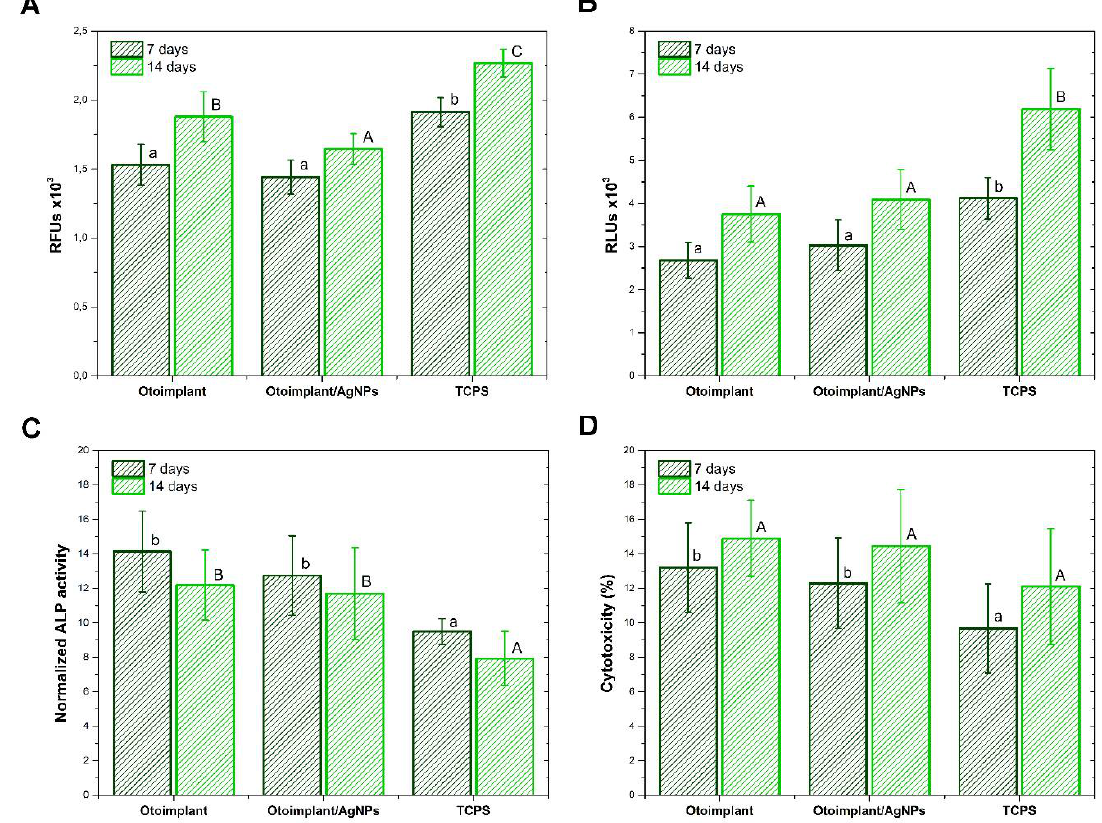
Figure 7. NHOst response after 7 and 14 days of culture in direct contact with the Otoimplant and Otoimplant/AgNPs: metabolic activity ( A ), the relative cell number ( B ), normalized alkaline phosphatase (ALP) activity ( C ), and cytotoxicity of materials ( D ). Statistically significant differences ( p < 0.05) between the tested materials are marked a–b for 7-day culture and A–C for 14-day culture, respectively.